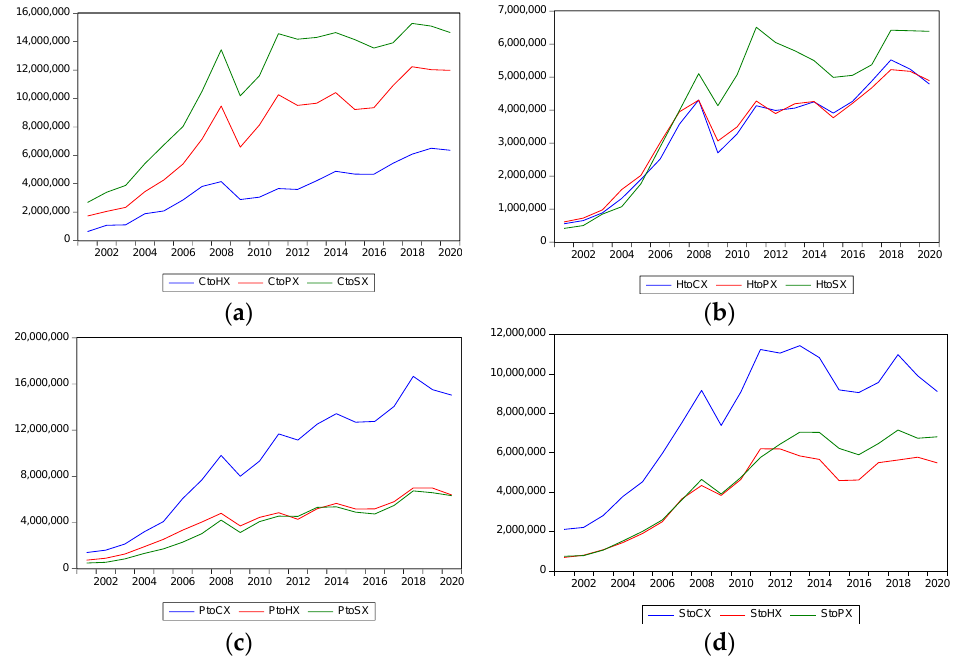
Figure 3. Exports of the countries from the other V4 members: ( a ) Czech Republic; ( b ) Hungary; ( c ) Poland; ( d )